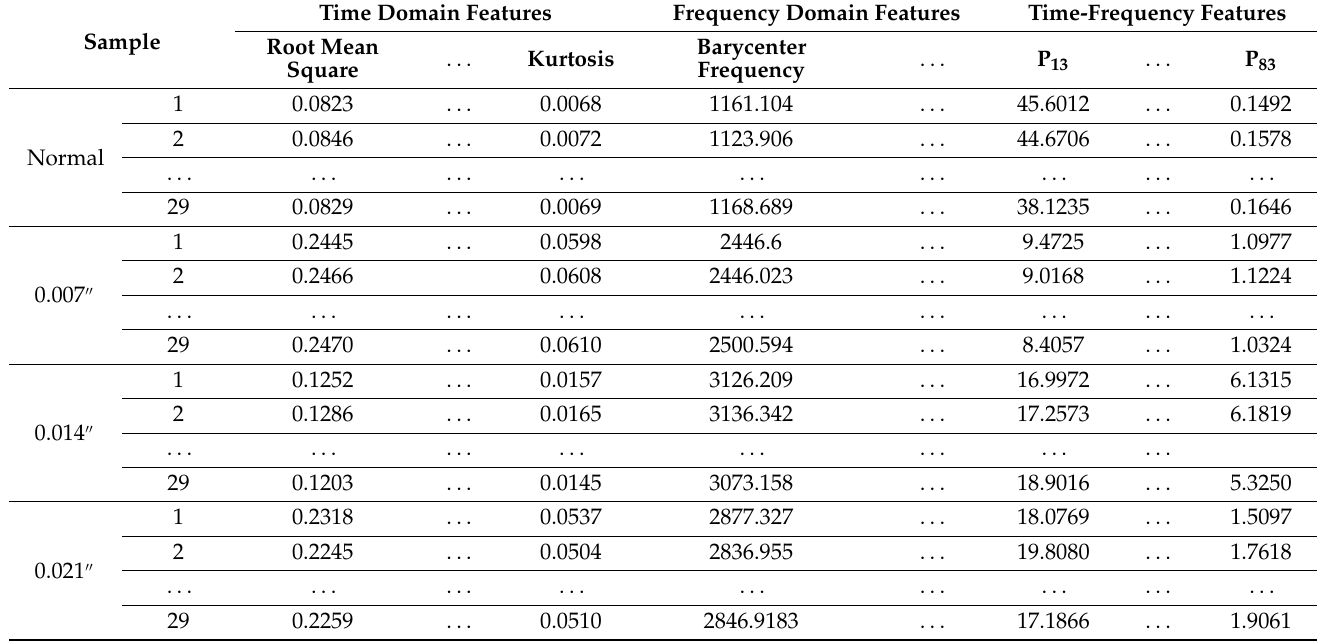
Table 1. Time-frequency characteristic